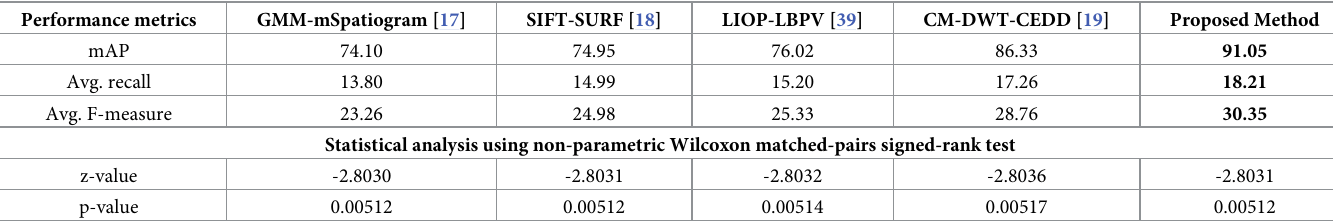
Table 3. Performance comparison of the proposed method with state-of-the-art methods on the Wang-B dataset. Performance metrics